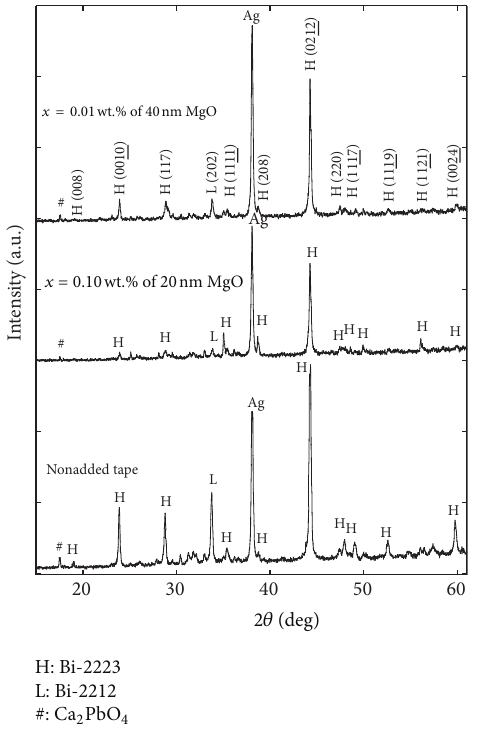
Figure 1: XRD patterns of (Bi, Pb)-2223(MgO) 0 wt.%, 𝑥 = 0.10 wt.% of 20 nm MgO, and 𝑥 = 0.01 wt.% of 40nm MgO heated for 50 h. The Ag peak is indexed to (111).